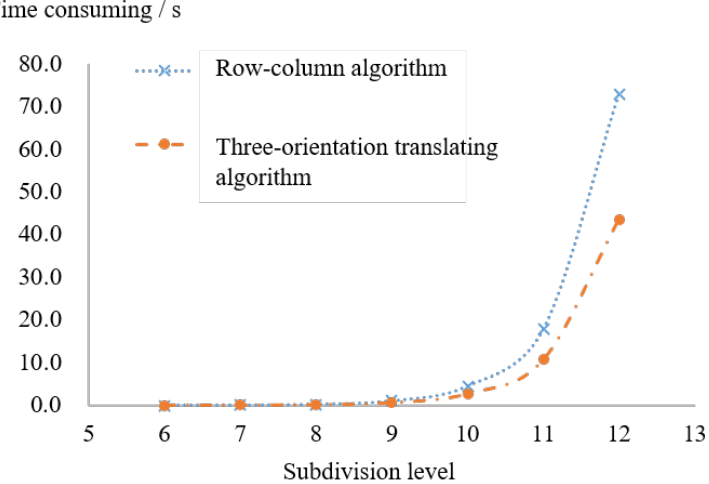
Figure 17. The algorithm efficiency analysis diagram of encoding conversion to row–column number.